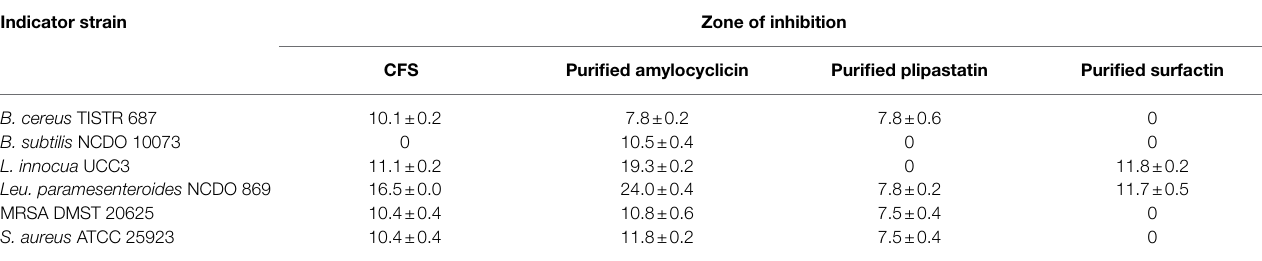
Data are expressed as mean ± standard deviation ( n = 3 ).